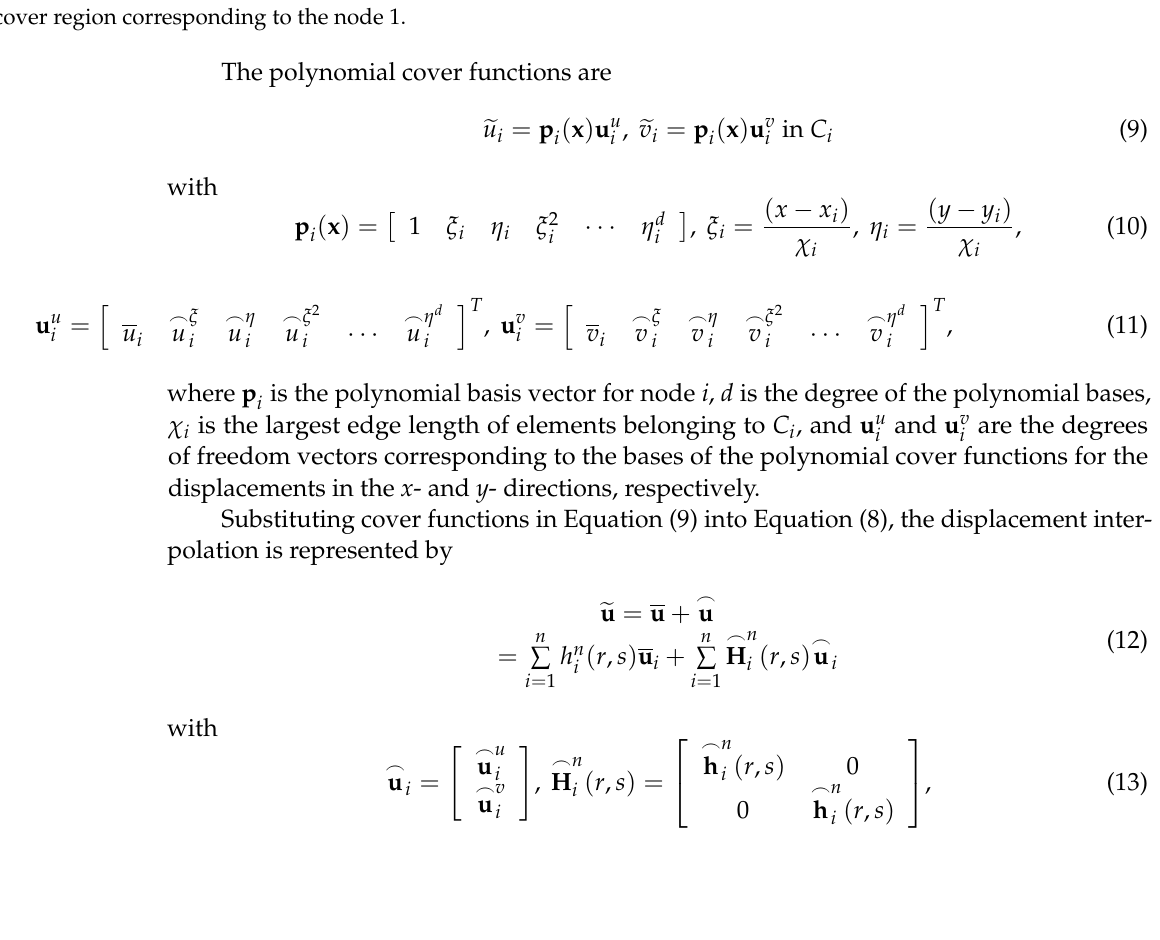
 ( , ) e c ε ( e , c ) (cid:95) of element 1 ε of element 1